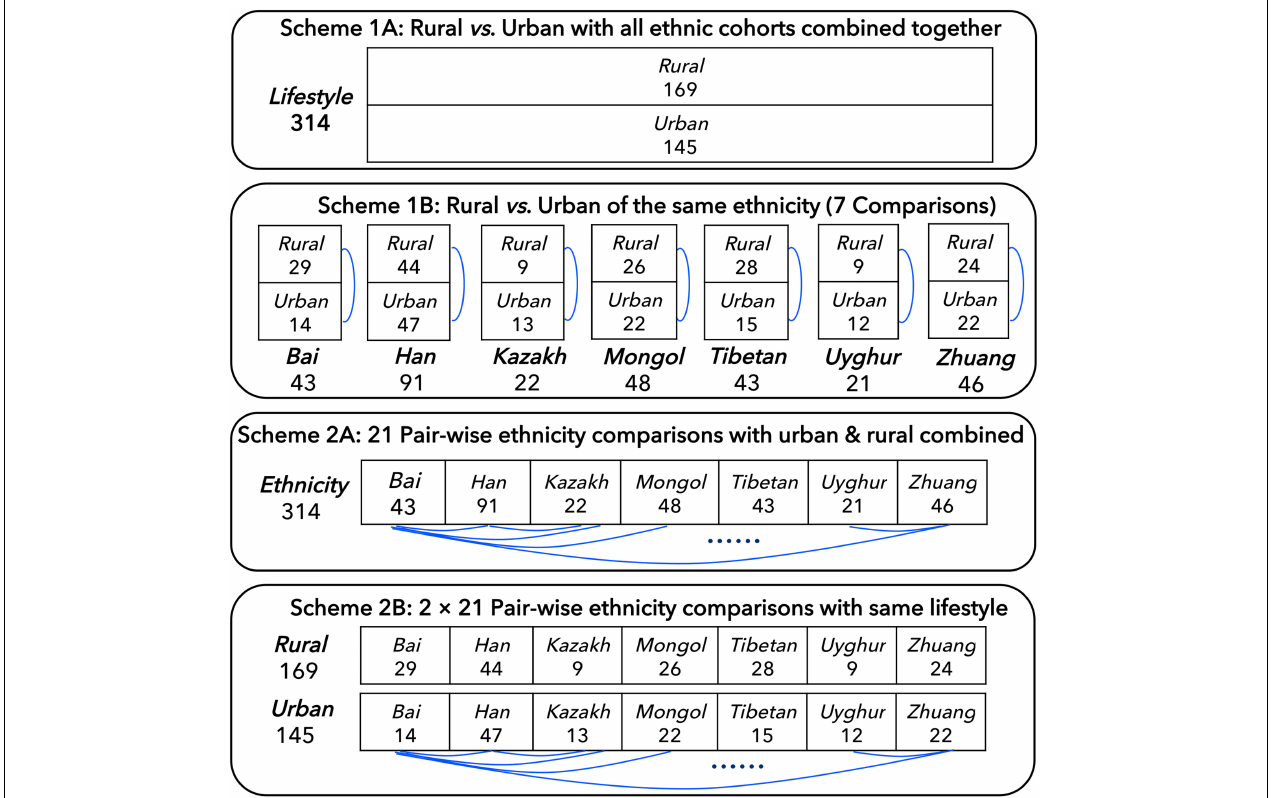
FIGURE 1 | Four schemes for comparing the Chinese gut microbiome from seven major Chinese ethnic cohorts with different lifestyles, which followed Ma